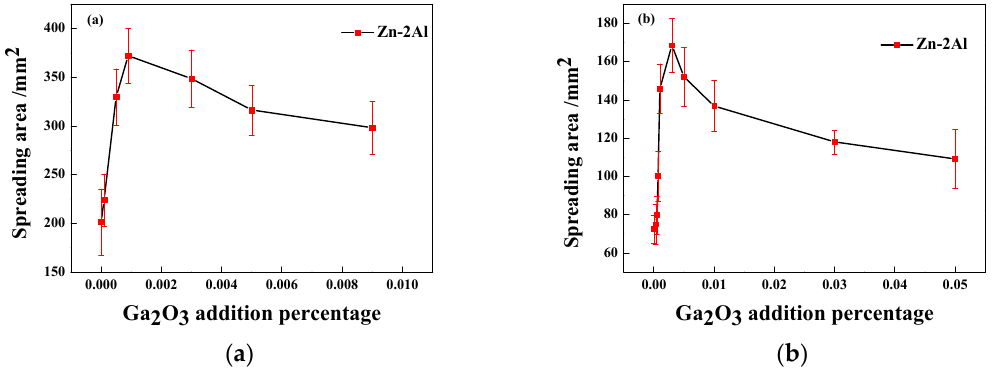
Figure 3. Effect of the Ga 2 O 3 concentration on spreading areas of Zn-2Al filler metal on base metal: ( a ) 5052 aluminum; ( b ) Q235 low-carbon steel.